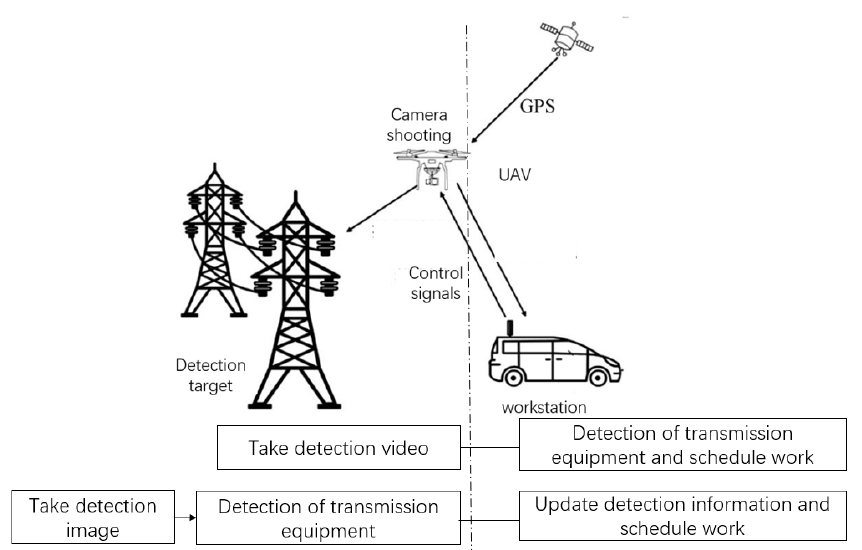
Figure 1. UAV inspection of transmission line.